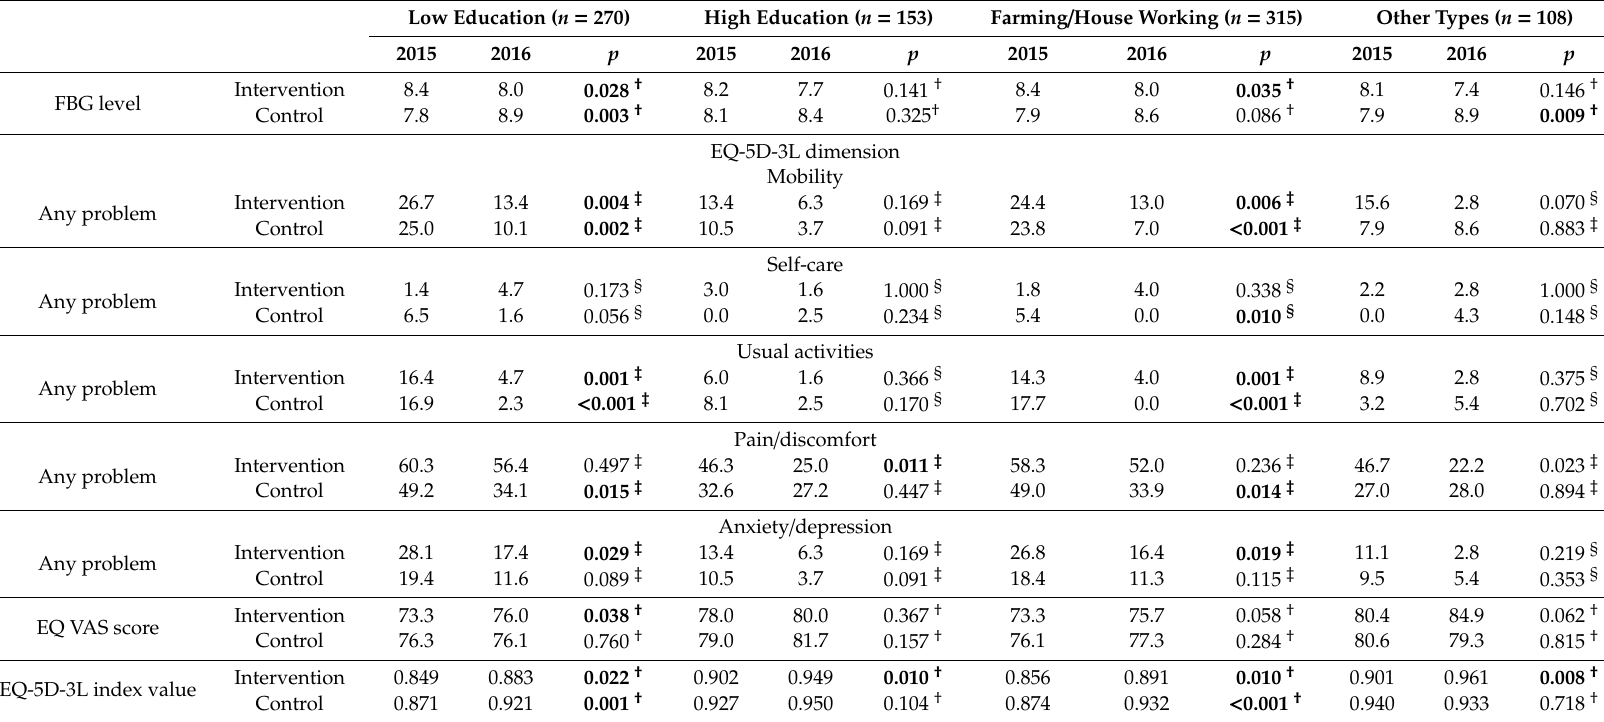
Table 3. FBG level (mmol / L, mean value), prevalence (%) of any problems by EQ-5D-3L dimensions, EQ VAS score (mean), and EQ index value (mean) for the intervention group ( n = 213) and control group ( n = 210) at baseline (2015) and follow-up (2016) stratified by education level and by occupation